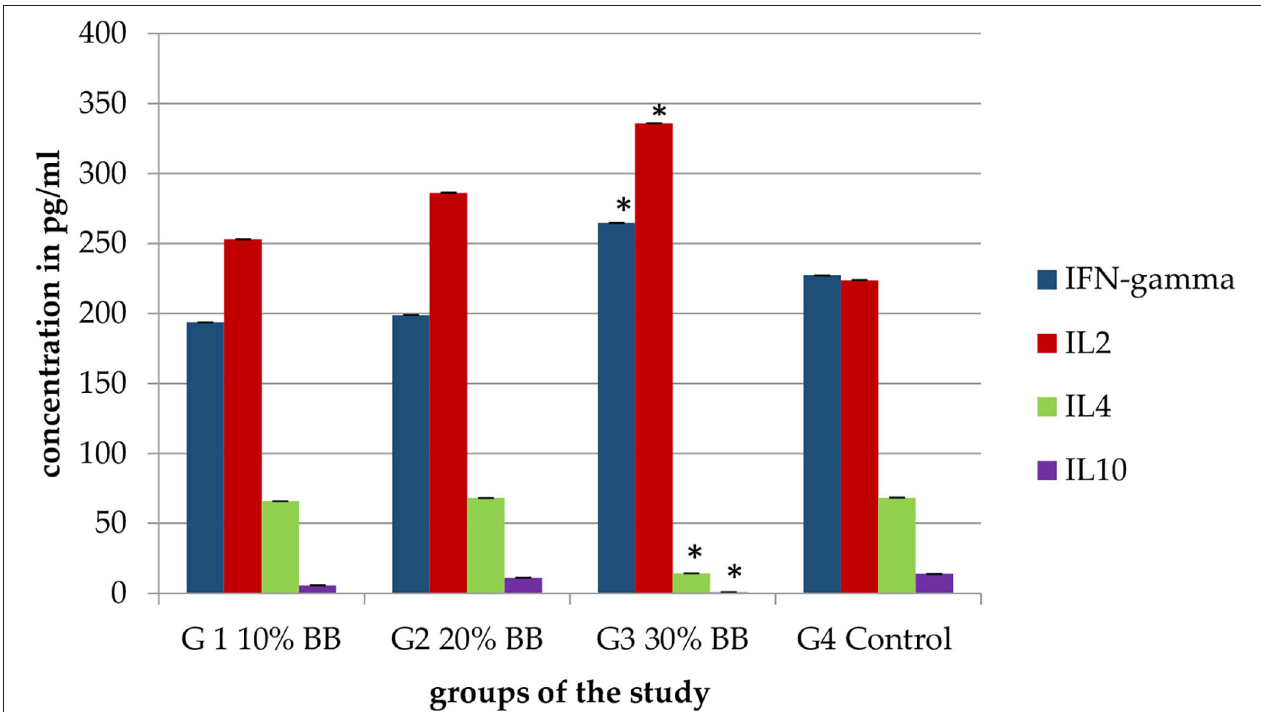
FIGURE 8 | Serum levels of IFN- γ , IL-2, IL-4, and IL-10 for the mice treated with increasing levels of barley bran. The G3 30% barley bran group significantly ( p < 0.05) induced higher levels of IFN- γ and IL-2 and lower levels of IL-4 and IL-10 compared with the control group. The * symbol indicates the significant